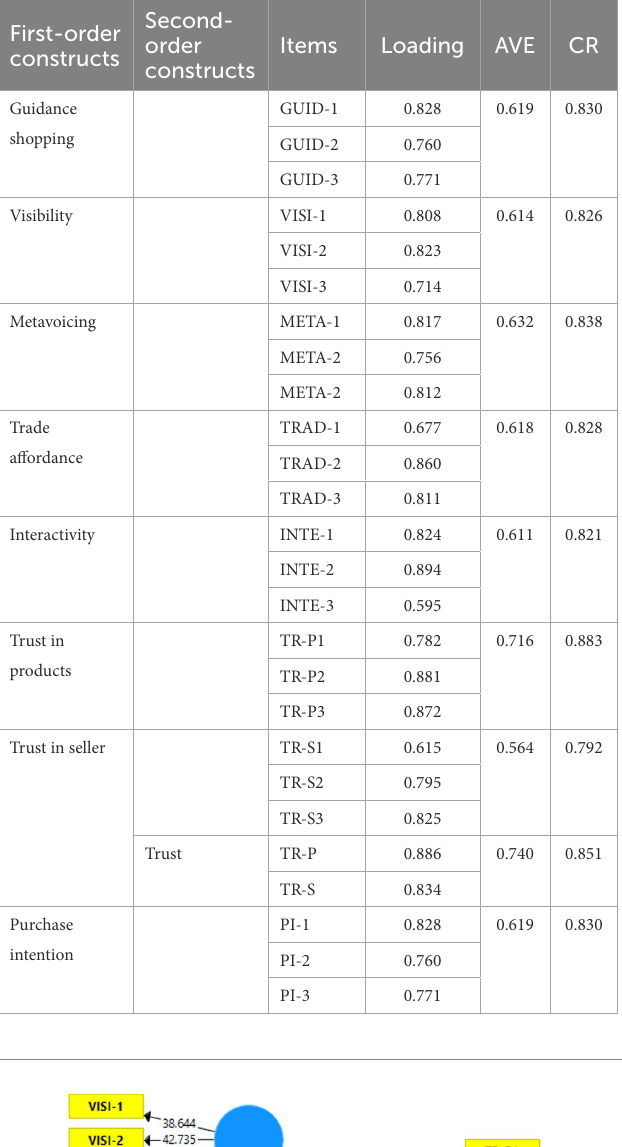
TABLE 2 Factor loading, reliability analysis and convergent